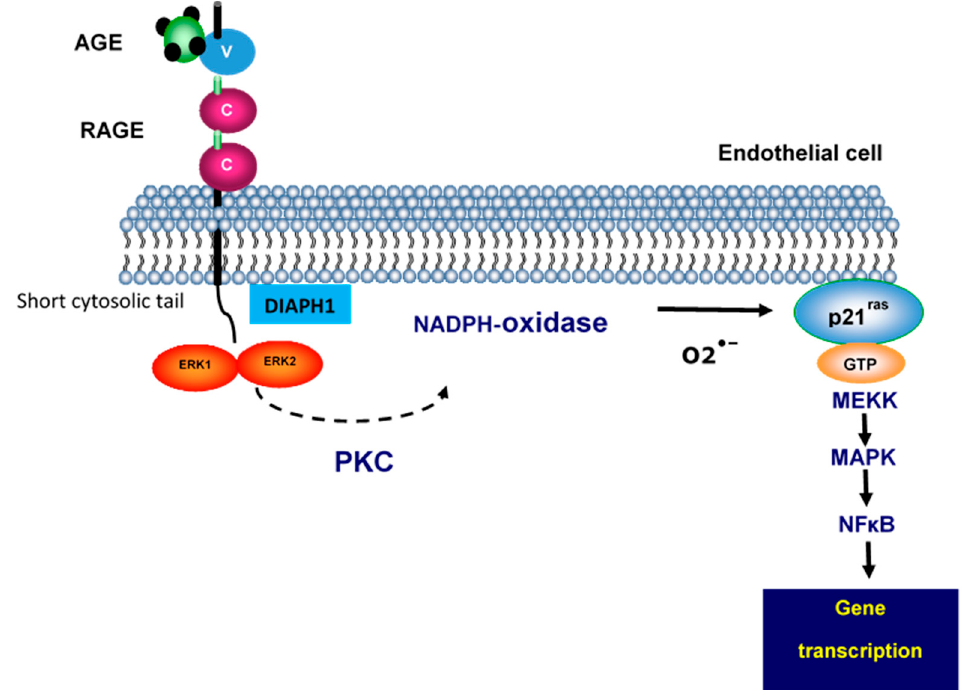
Figure 7. Binding of AGE to the endothelial cell receptor, RAGE. This is followed by a series of reactions involving diaphenous-1 (DIAPH 1), ERK1, ERK2, and protein kinase C, which lead to NADPH oxidase activation and the formation of reactive oxygen intermediates. Through a pathway including the MAP kinase, NF Κ B becomes activated and induces gene transcription.